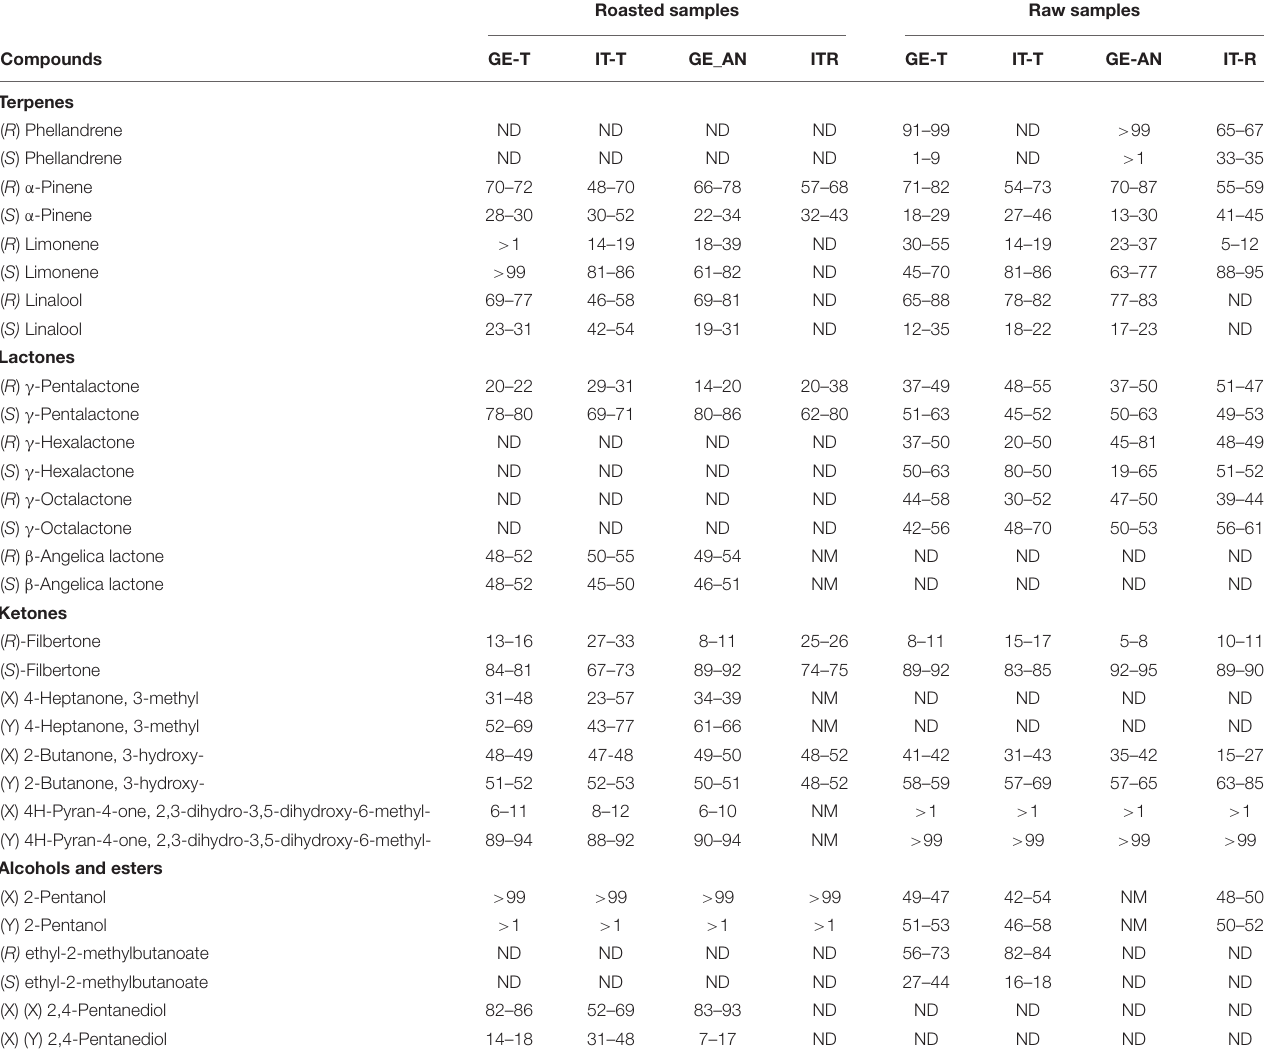
TABLE 2 | Percentage enantiomeric composition of the main chiral markers of the hazelnut